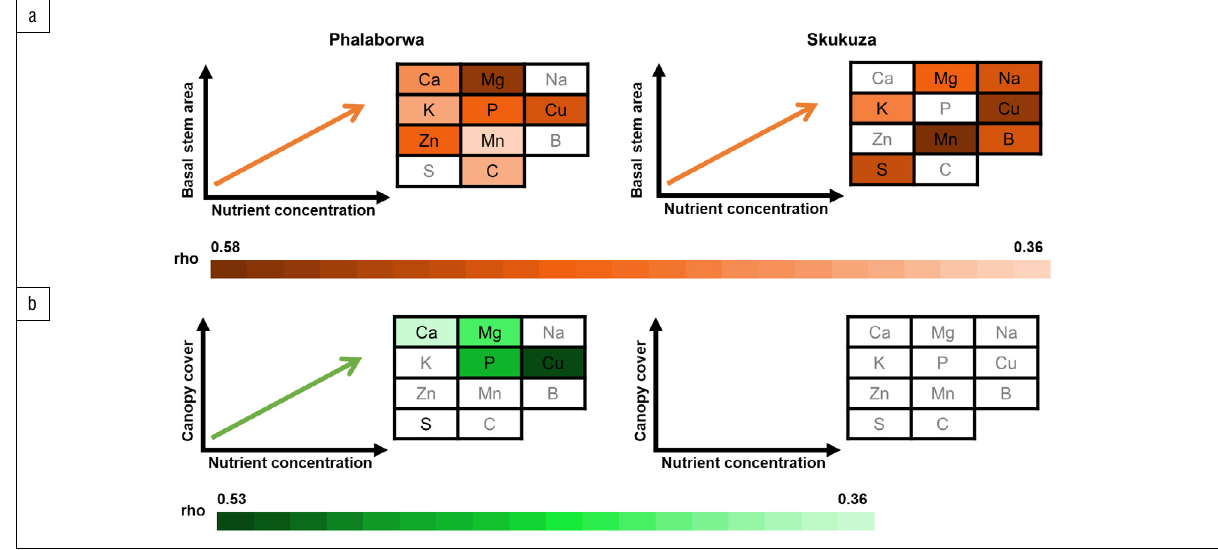
Figure 1: Significant correlations between (a) basal stem area and soil nutrients and (b) canopy cover and soil nutrients at the Phalaborwa ( n =32) and Skukuza ( n =20) study sites in the Kruger National Park, South Africa. Colour intensity reflects the relative strengths of the significant correlations as per the rho